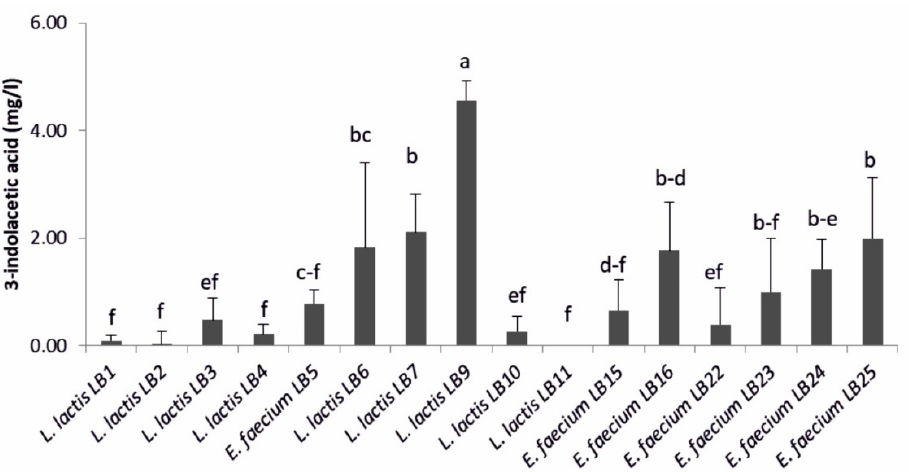
Figure 1. 3-indolacetic acid amount produced by lactic acid bacteria ( n = 3). Means ( ± SD) followed by the similar letter(s) are not significantly different at the 5% probability level (LSD test).